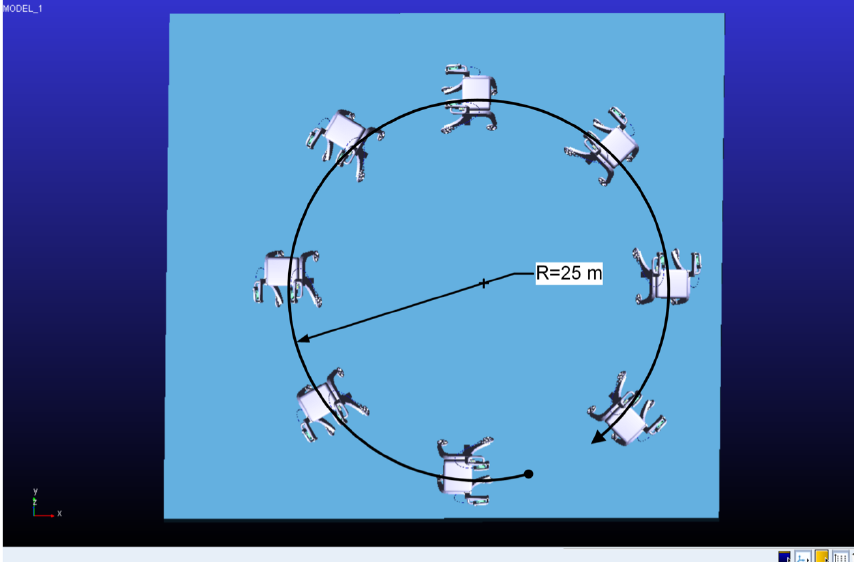
Figure 13. The tracking results of circle